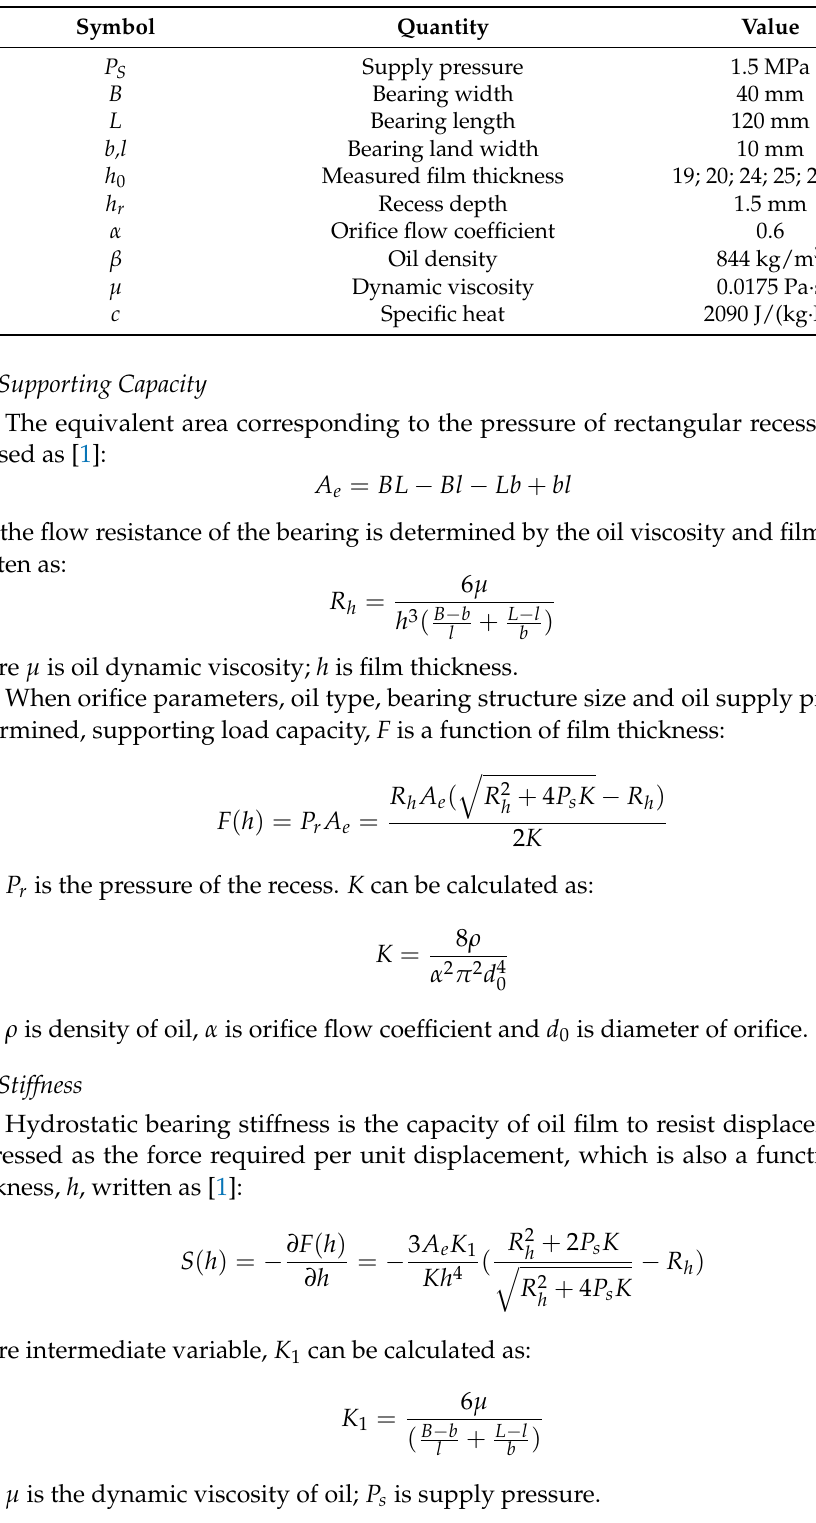
Table 1. Structural and oil parameters of hydrostatic